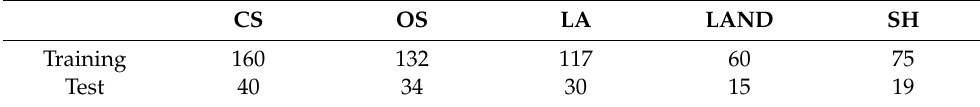
Table 4. Number of samples of different